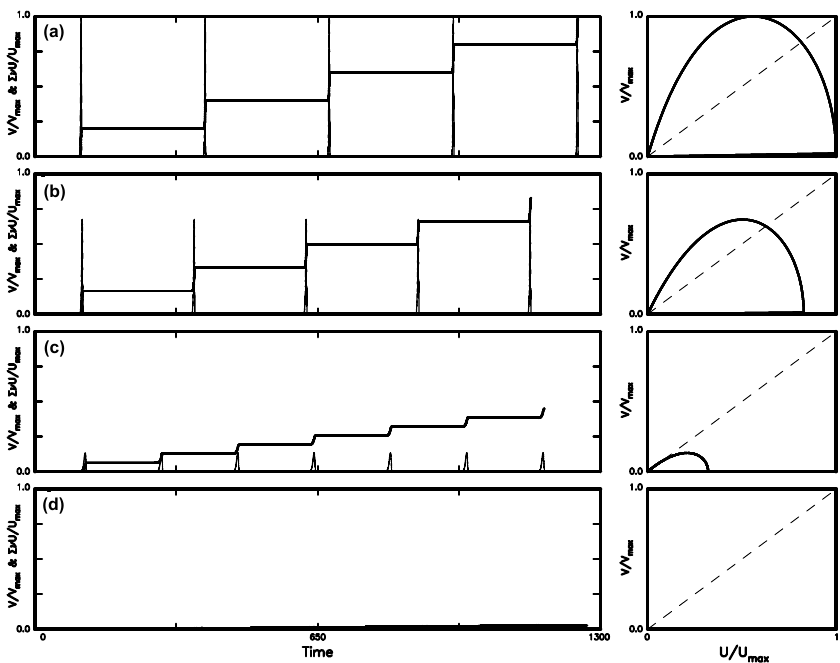
Figure 4. The time variations in V/V max (thin solid line) and cumulative slip (cid:54)U/U max (solid line) and the phase portrait of V/V max versus U/U max (solid line) for four values of U c : (a) for U c = 0.2; (b) for U c = 0.4; (c) for U c = 0.8; and (d) for U c = 1.0 when η = 0.0.